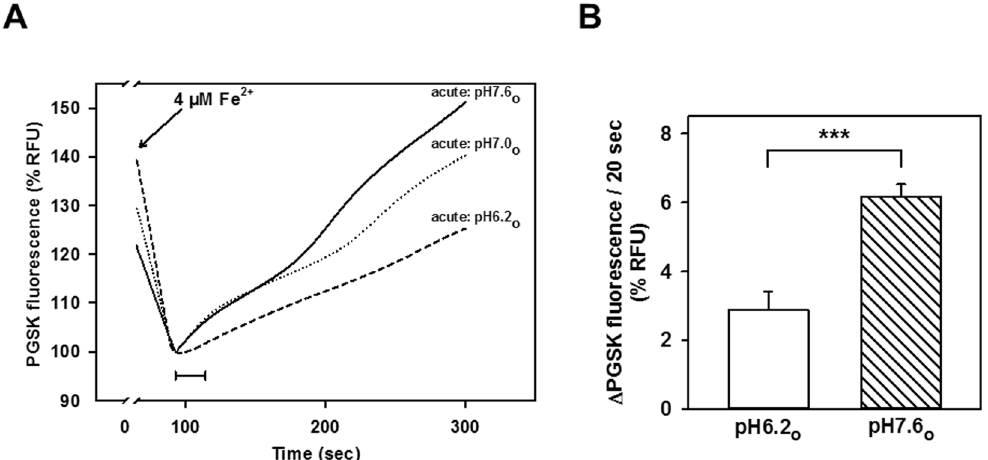
Figure 7. Fe 2 + efflux from rat kidney cortex mitochondria is strongly reduced by an inward-directed proton gradient. PGSK-loaded mitochondria (pH 7.0 i ) from rKC were suspended in pH 6.2 o , 7.0 o , or 7.6 o assay buffers and immediately assayed for quenching induced by 4 µ M Fe 2 + . ( A ) Representative traces of the fluorescence time course are shown. Fluorescence data were normalized to the respective initial value of the second phase. ( B) Statistical analyses of second phase PGSK quenching. Initial slopes of quenching, as indicated by the 20s-scale bar in ( A ), are plotted for pH6.2 and pH7.6, and represent means ± SE of 10–11 measurements in 3 independent experiments. *** P < 0.001. RFU, relative fluorescence units.